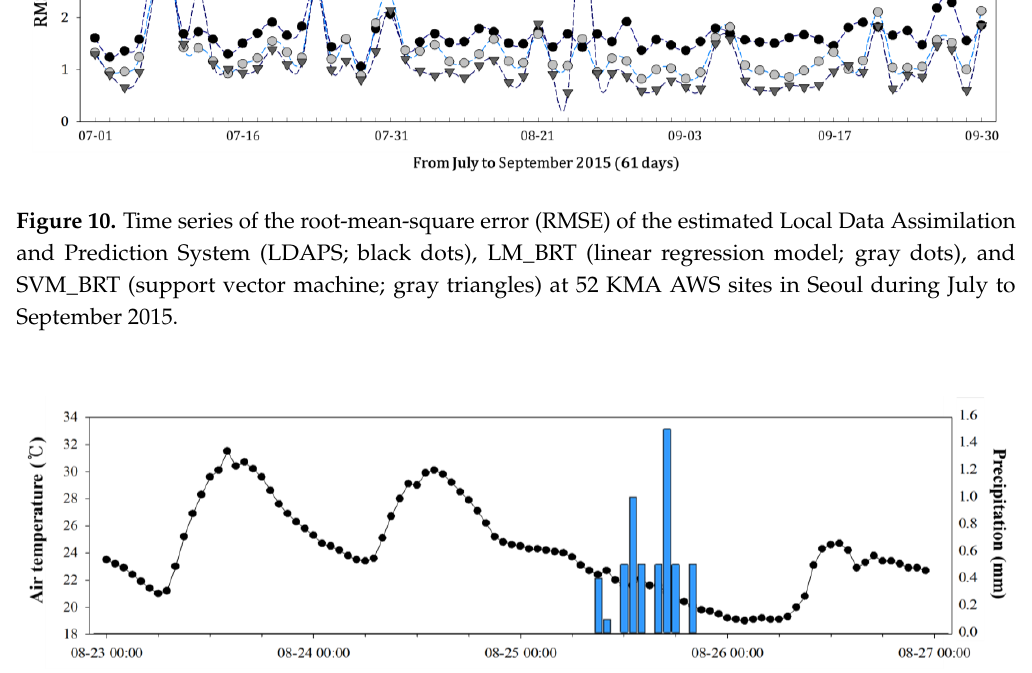
Figure 10. Time series of the root-mean-square error (RMSE) of the estimated Local Data Assimilation and Prediction System (LDAPS; black dots), LM_BRT (linear regression model; gray dots), and SVM_BRT (support vector machine; gray triangles) at 52 KMA AWS sites in Seoul during July to September 2015.